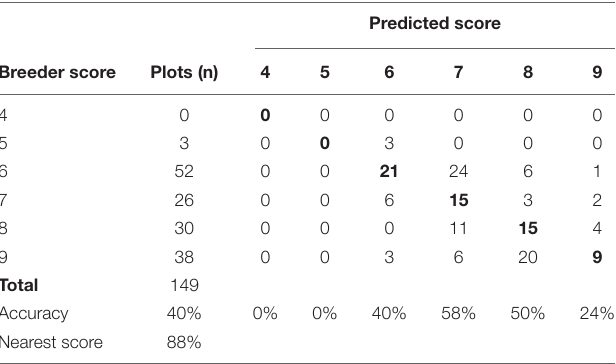
The bold figures represent the visual scores which were correctly classified by logistic